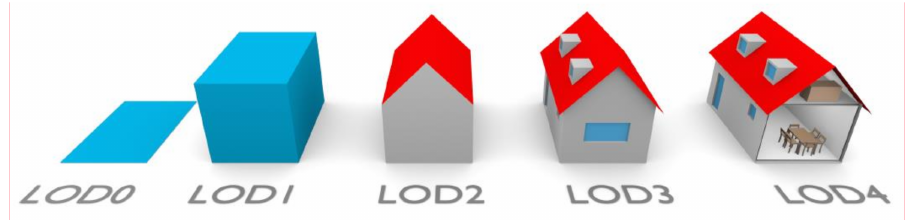
Figure 1. Five representations of a building in level of detail (LOD)0 to LOD4